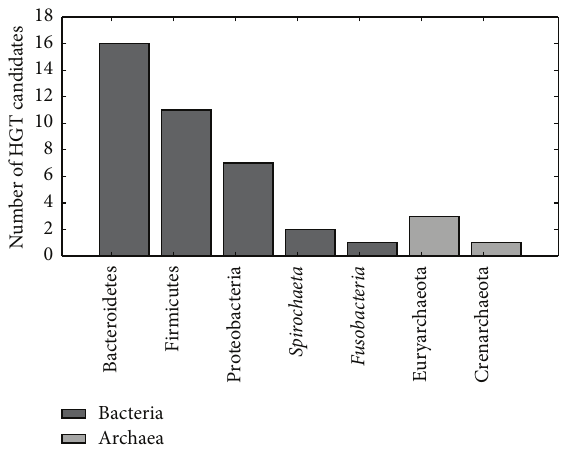
Figure 1: Number of genes obtained by each donor phylum identified in phylogenetic